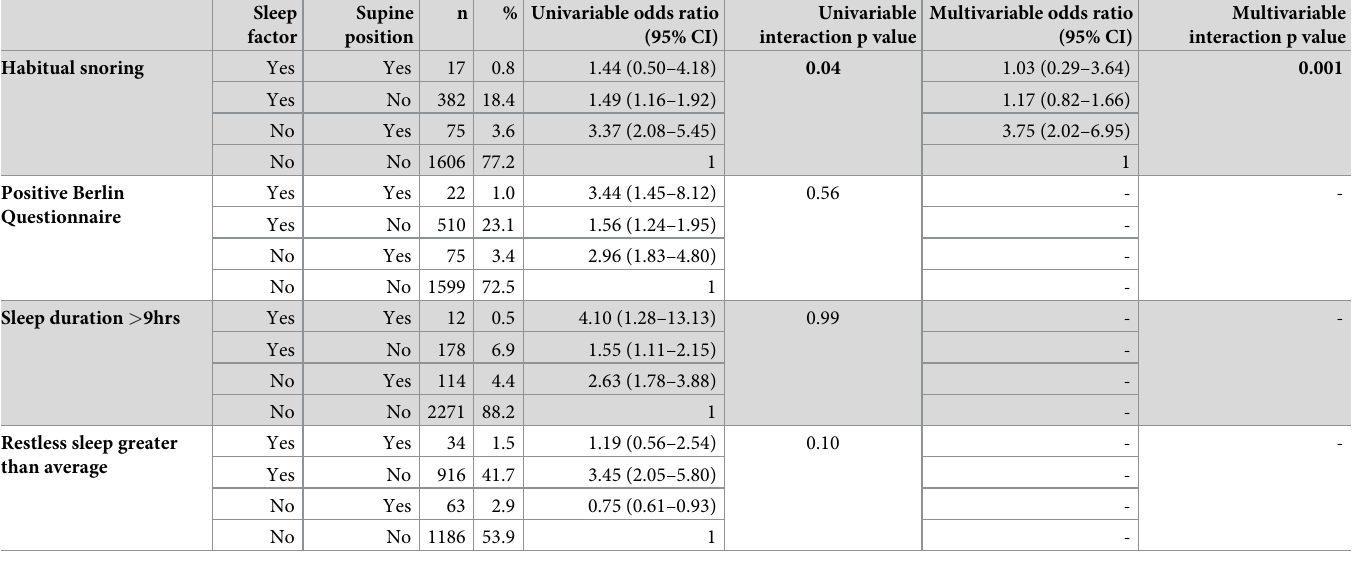
Participants with missing data were excluded from the analysis. No imputation for missing